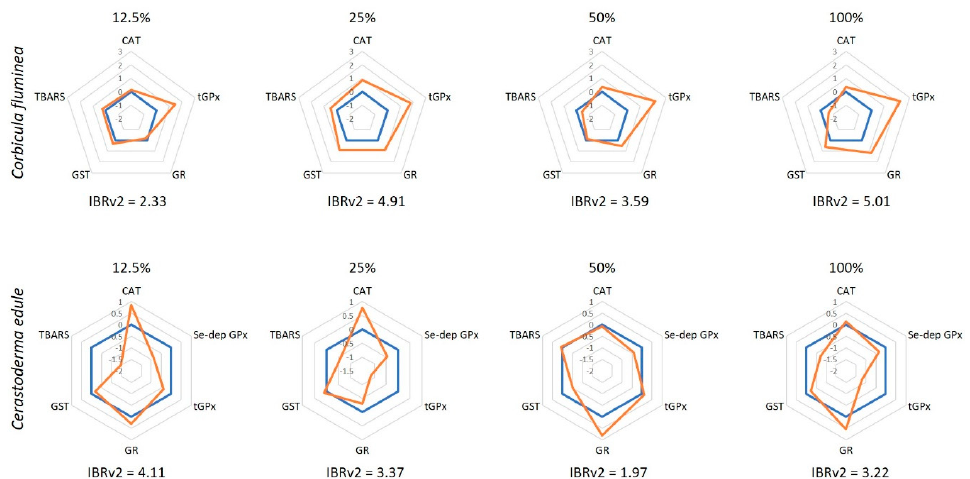
Figure 2. Integrated biomarker response (IBRv2) values of Corbicula fluminea and Cerastoderma edule individuals after 96 h of exposure to aqueous extracts of ash (AEA) at different concentrations (0, 12.5, 25, 50, and 100%). The orange line represents the IBRv2 index of AEAs-exposed organisms and is presented relatively to the control organisms (blue line; 0). Values above 0 indicate biomarker induction, whereas values below 0 indicate inhibition.